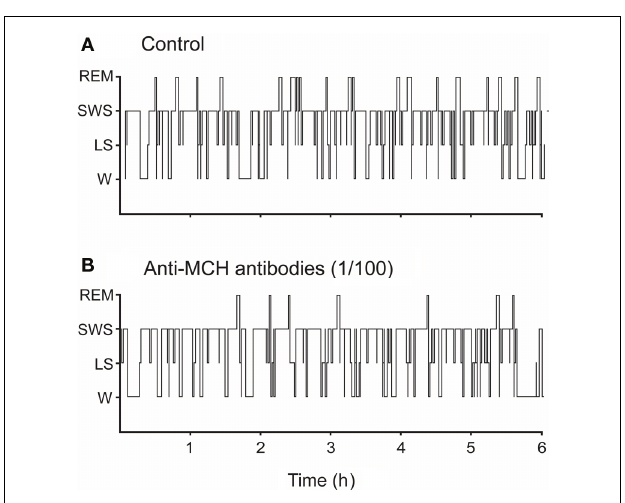
FIGURE 3 | Representative hypnograms illustrating the occurrence of wakefulness and sleep following microinjection of anti-MCH antibodies (immunoneutralization) into the dorsal raphe nucleus. The effects of the vehicle (A) and 1/100 dilution dose of anti-MCH (B) are presented. Comparing to control, the hypnogram corresponding to anti-MCH microinjection depicts a substantial decrease in the number of REM sleep episodes.This figure was modified from Lagos et al.